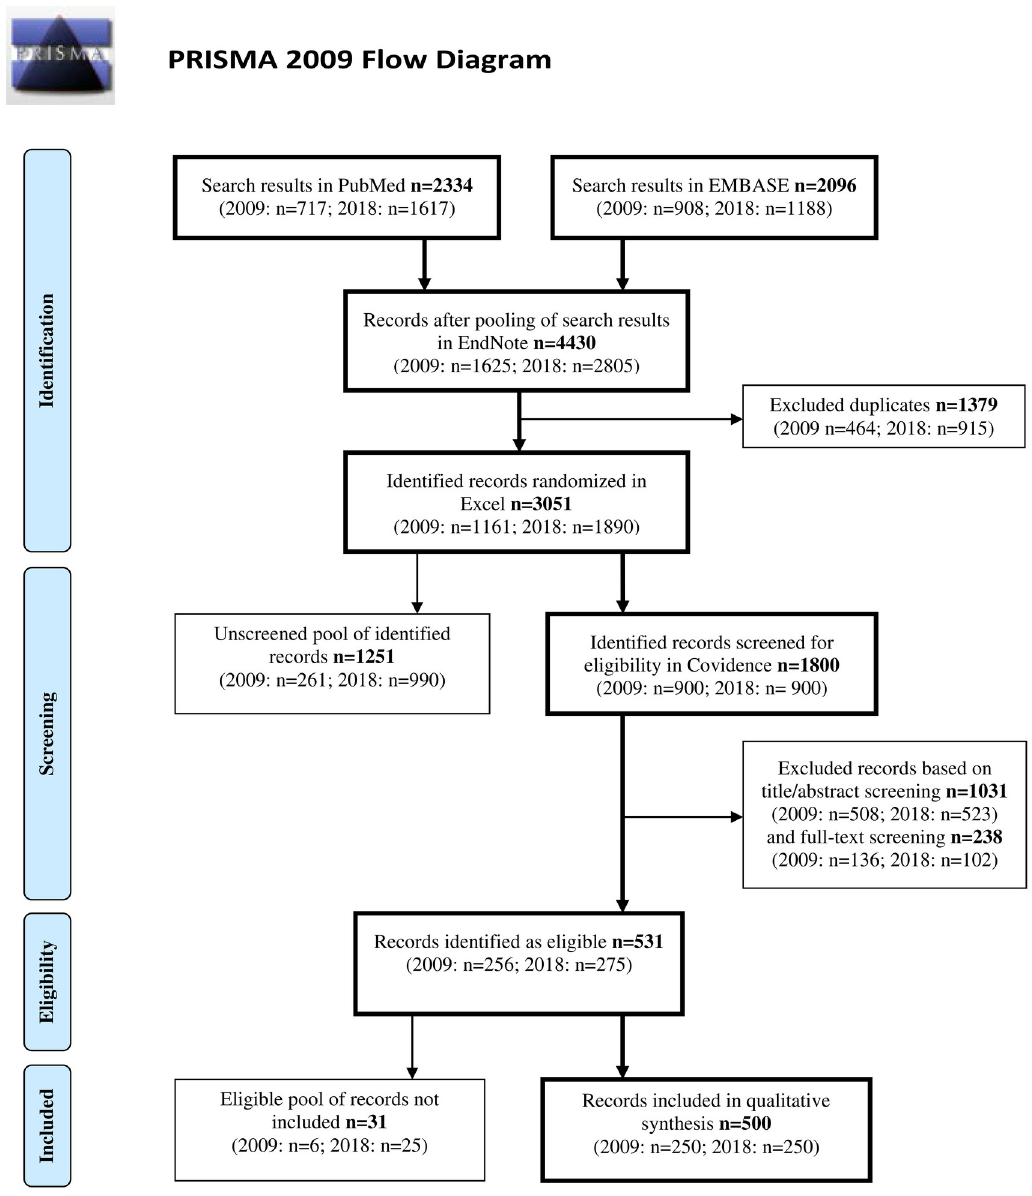
Fig 1. Flow diagram describing the random sampling, screening, and selection of